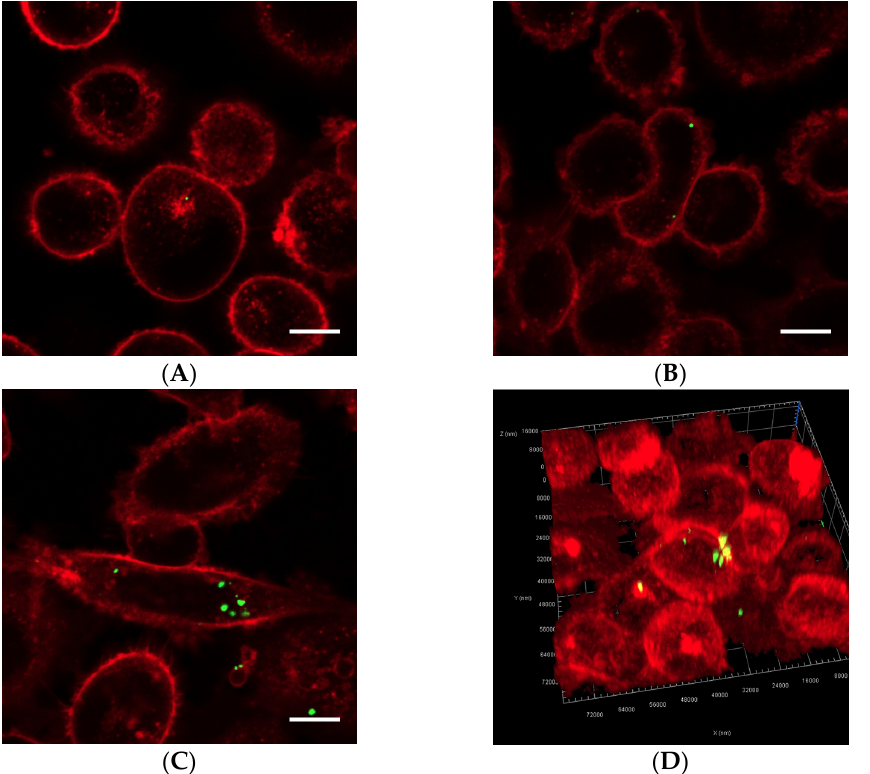
Figure 5. Representative confocal images of cells displaying Cell Masks (red) and nanoparticles (green). In addition to the free nanoparticles, the cells were treated with ( A ) nanoparticle-loaded microbubbles but no ultrasound at 37 ° C (control), ( B ) Sonazoid and ultrasound at 37 ° C or ( C ) nanoparticle-loaded microbubbles and ultrasound at 37 ° C. Both individual nanoparticles and groups of a few can be observed, as well as larger nanoparticle clusters in C. The scale bars are 10 µm. ( D ) 3D image of a cell where the nanoparticles inside the cell (green) and on the cell surface (yellow) are visualized.